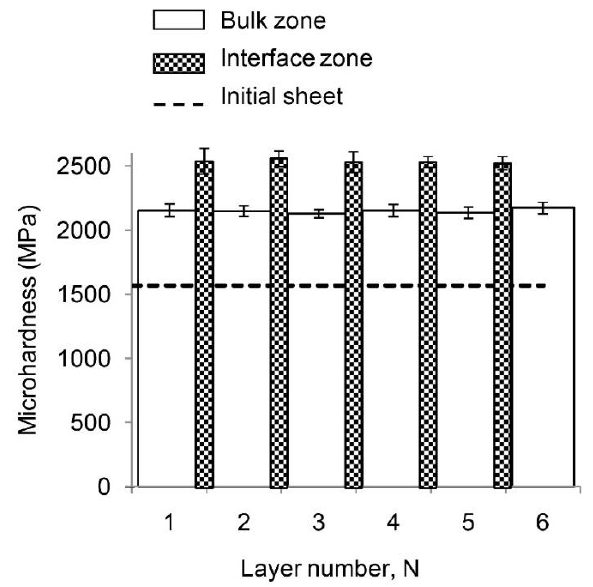
Figure 7. Microhardness in different zones of consolidated nickel sample. Dashed line indicates the microhardness of the initial sheet.